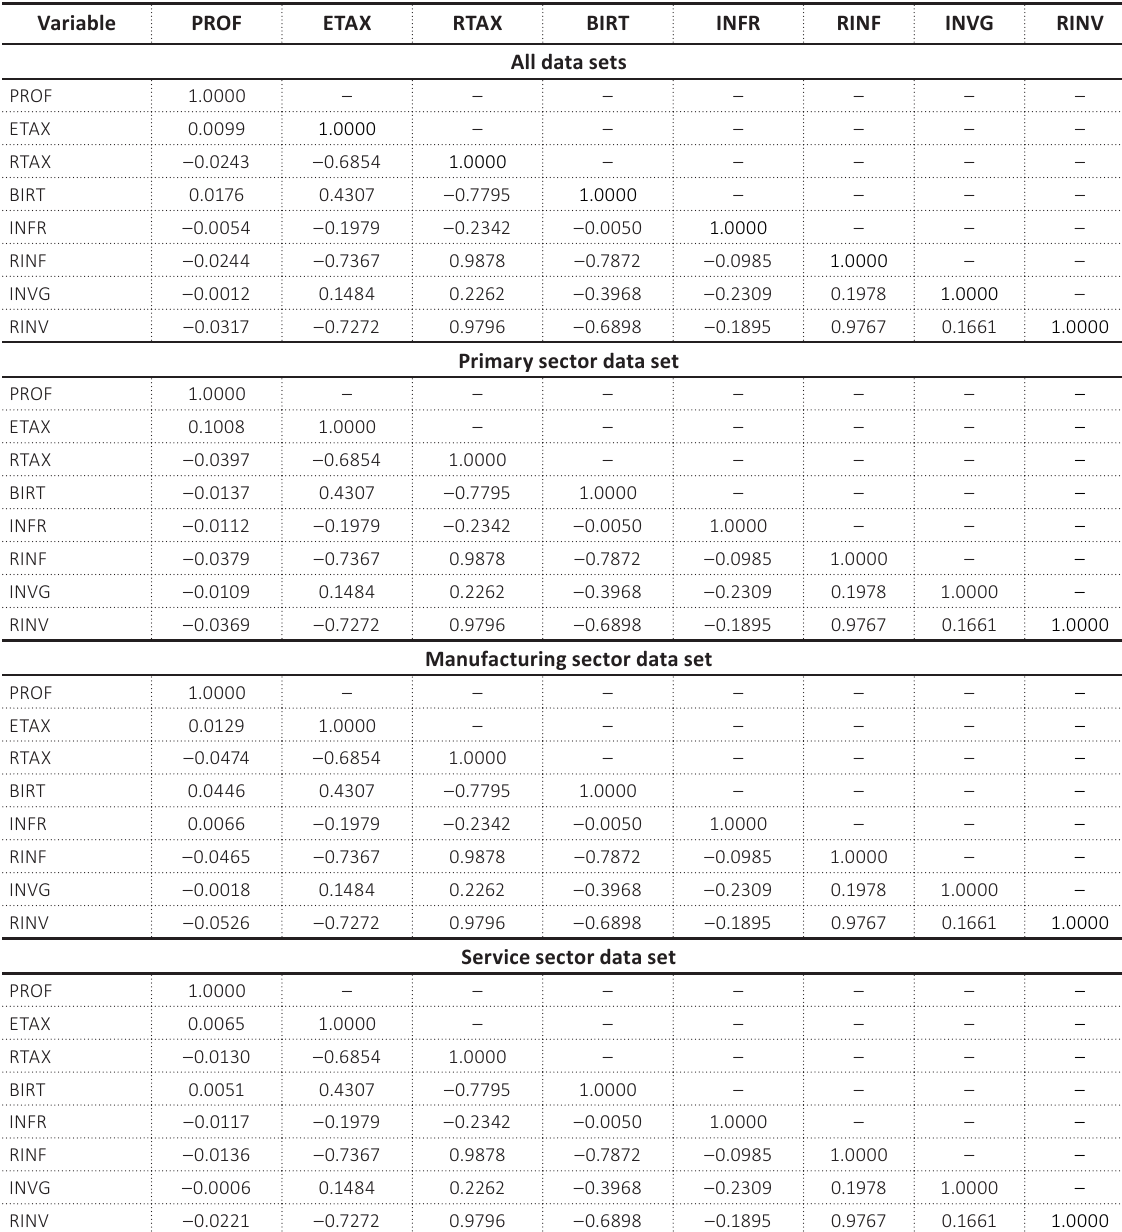
Table 3. Correlation matrix between the variables of each